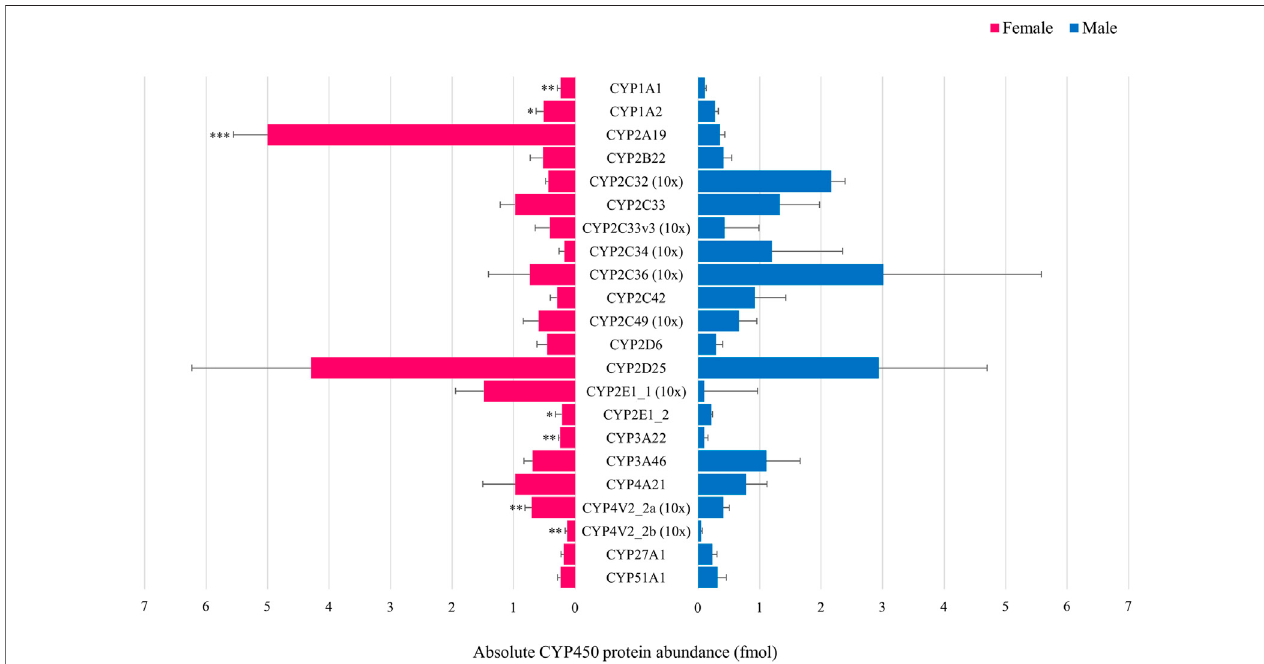
FIGURE 4 | Comparison of the absolute CYP protein abundance in adult female (pink) and male (blue) Göttingen Minipig. Bars represent mean ± S.D. Statistically signi fi cantsex-relateddifferenceswereobservedforCYP1A1,CYP1A2,CYP2A19,CYP2E1_2,CYP3A22,CYP4V2_2aandCYP4V2_2b,highestvalueswereobserved in the female Göttingen Minipig for these isoforms. For visualization purposes, the CYP2C33, CYP2C33v3, CYP2C34, CYP2C36, CYP2C49, CYP2E1_1, CYP4V2_2a and CYP4V2_2b absolute protein abundance values were magni fi ed 10 times. * ( p < 0.05), ** ( p < 0.01), *** ( p <